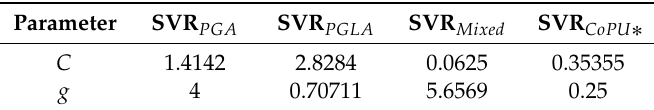
Table 3. Optimal parameters of SVR.